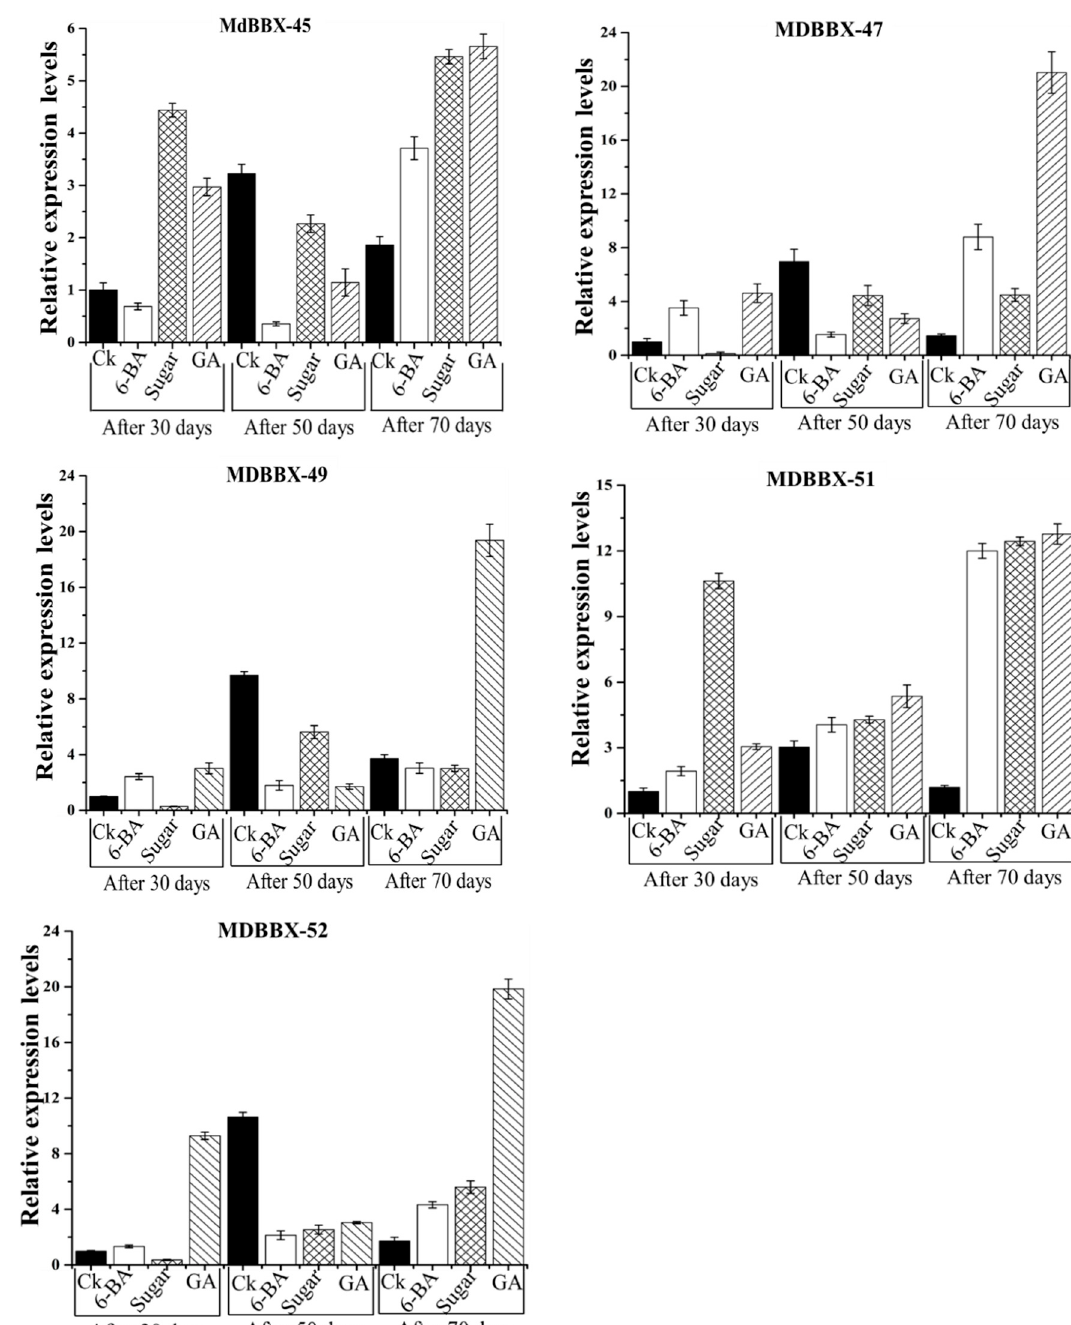
Figure 9. Inducible expression profile of apple BBX gene family members in response to flowering-related treatments (6-BA, Sugar, and GA), where Ck represents the control, 6-BA represents 6-benzylaminopurine, and GA represents gibberellins. The x -axis indicates the treatment. The y -axis shows the relative expression level of each treatment compared to control (Ck). The error bars indicate the standard deviations of the three independent qRT-PCR replicates.